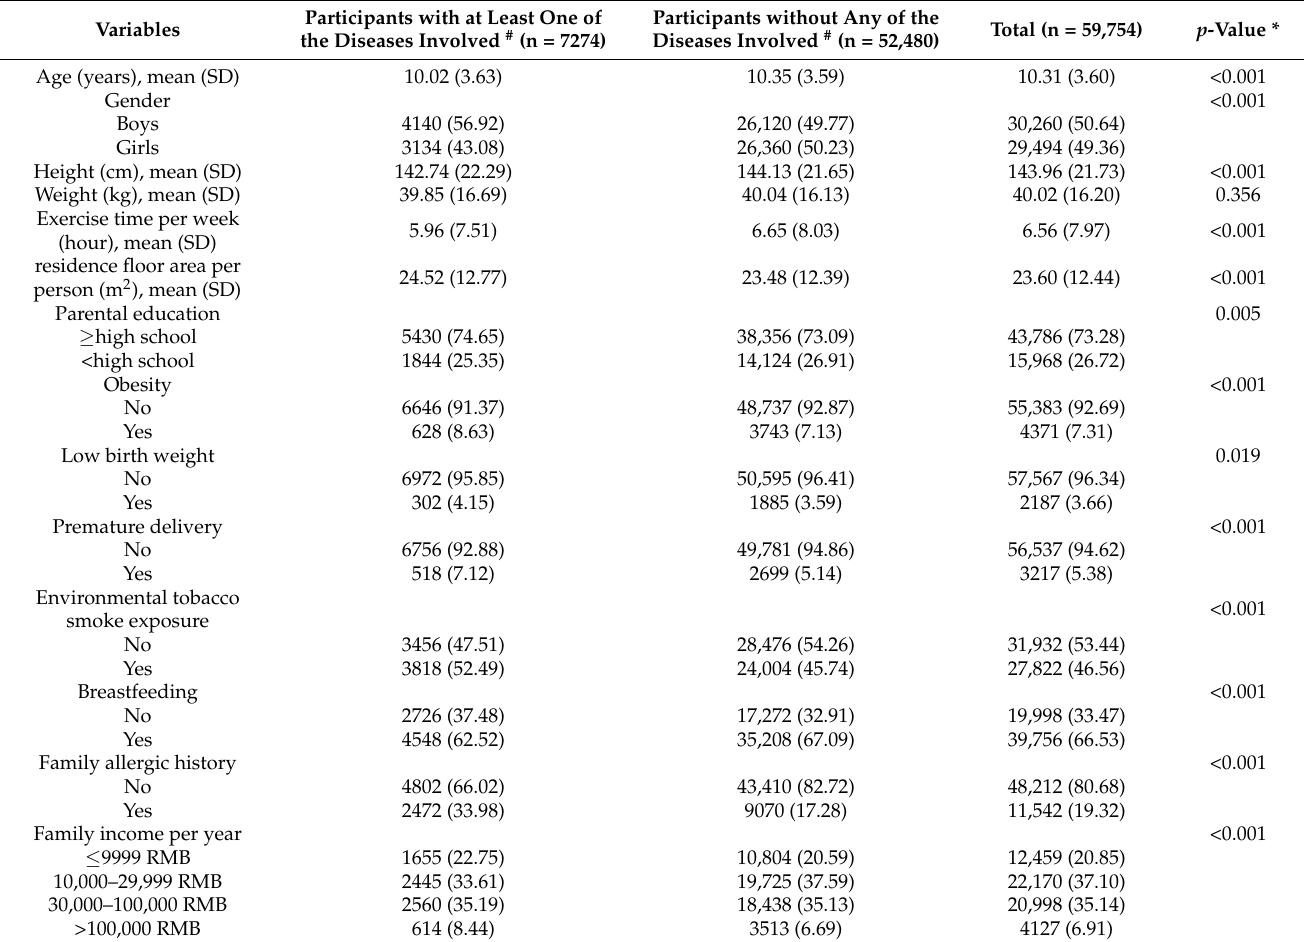
Table 1. Characteristics of study population in the Seven Northeastern Cities (SNEC) Study.